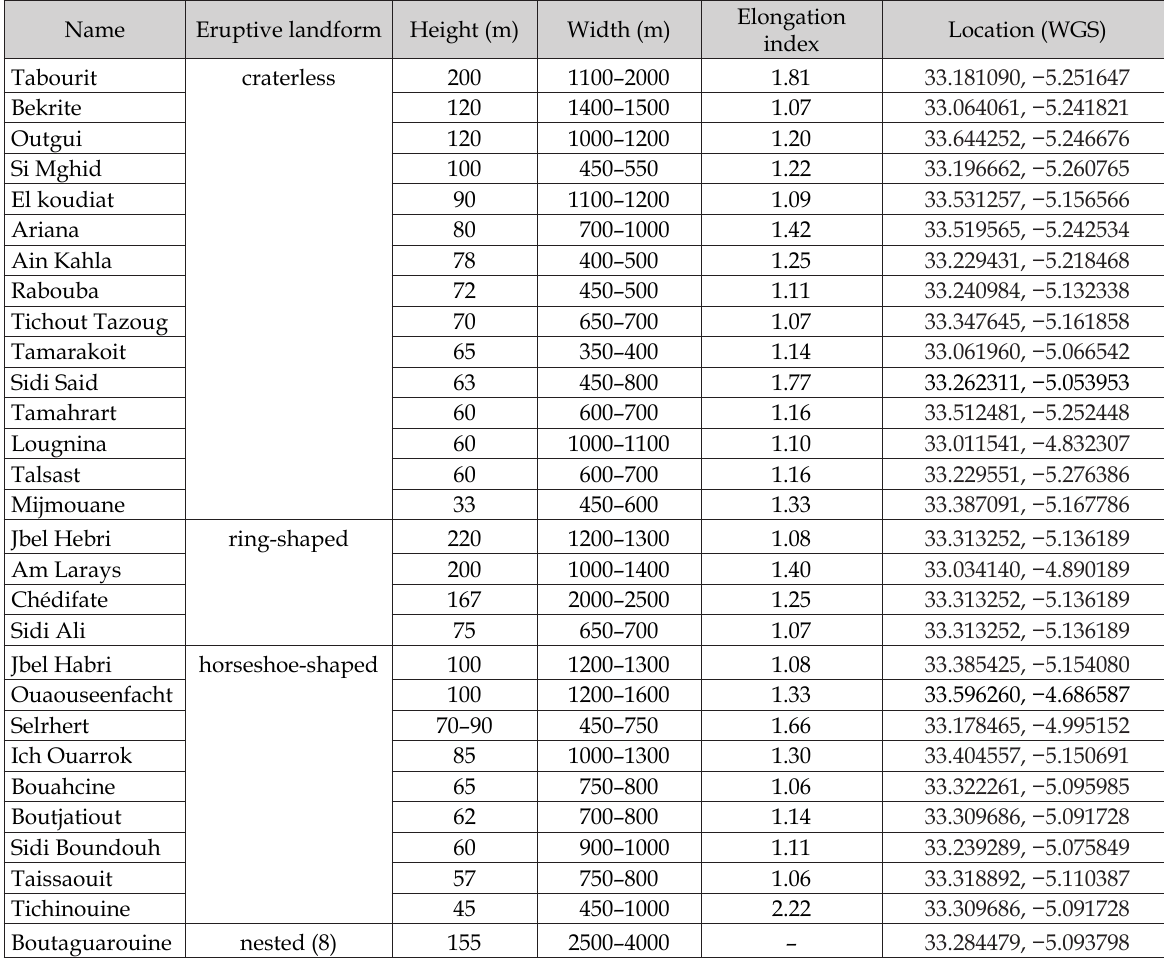
Table 1. Classification table of cones according to their eruptive landform, height, width, elongation index, and the geographic